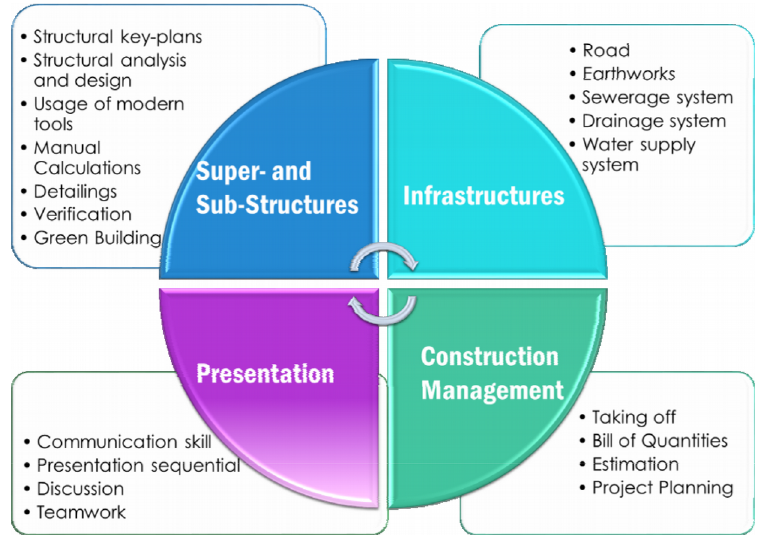
Figure 1. Scopes of the capstone project in